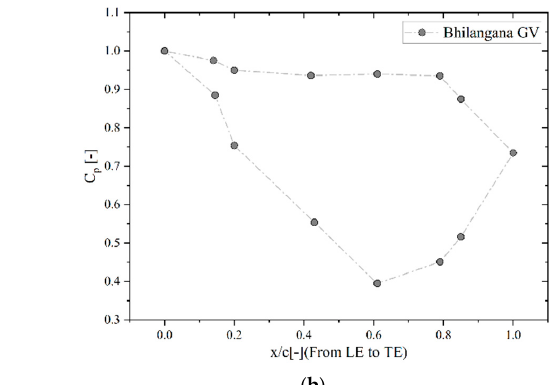
Figure 7. Validation of the CFD results with the experiment: ( a ) Velocity normal to camber line from LE to TE and pressure distribution in GV for NACA 0012 hydrofoil; ( b ) reference case GV profile.